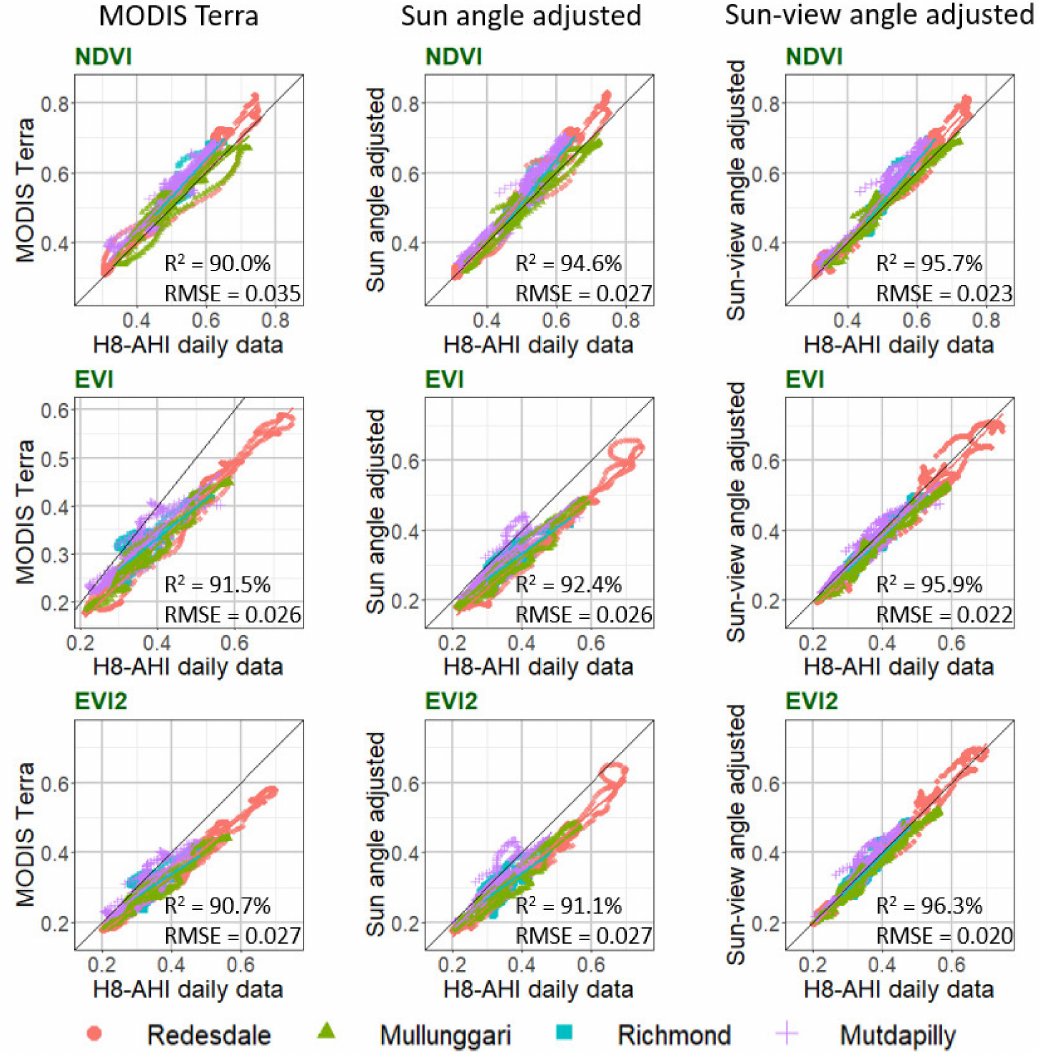
Figure 12. Global cross-site relationships between AHI and MODIS VI values using Terra MODIS standard product ( left ), MODIS sun angle adjusted to solar noon / nadir view ( middle ), and MODIS solar noon and view angle adjusted to AHI fixed view angle ( right ). R 2 was calculated using data points across the four sites ( p -values were lower than 2.2 × 10 − 16 for all